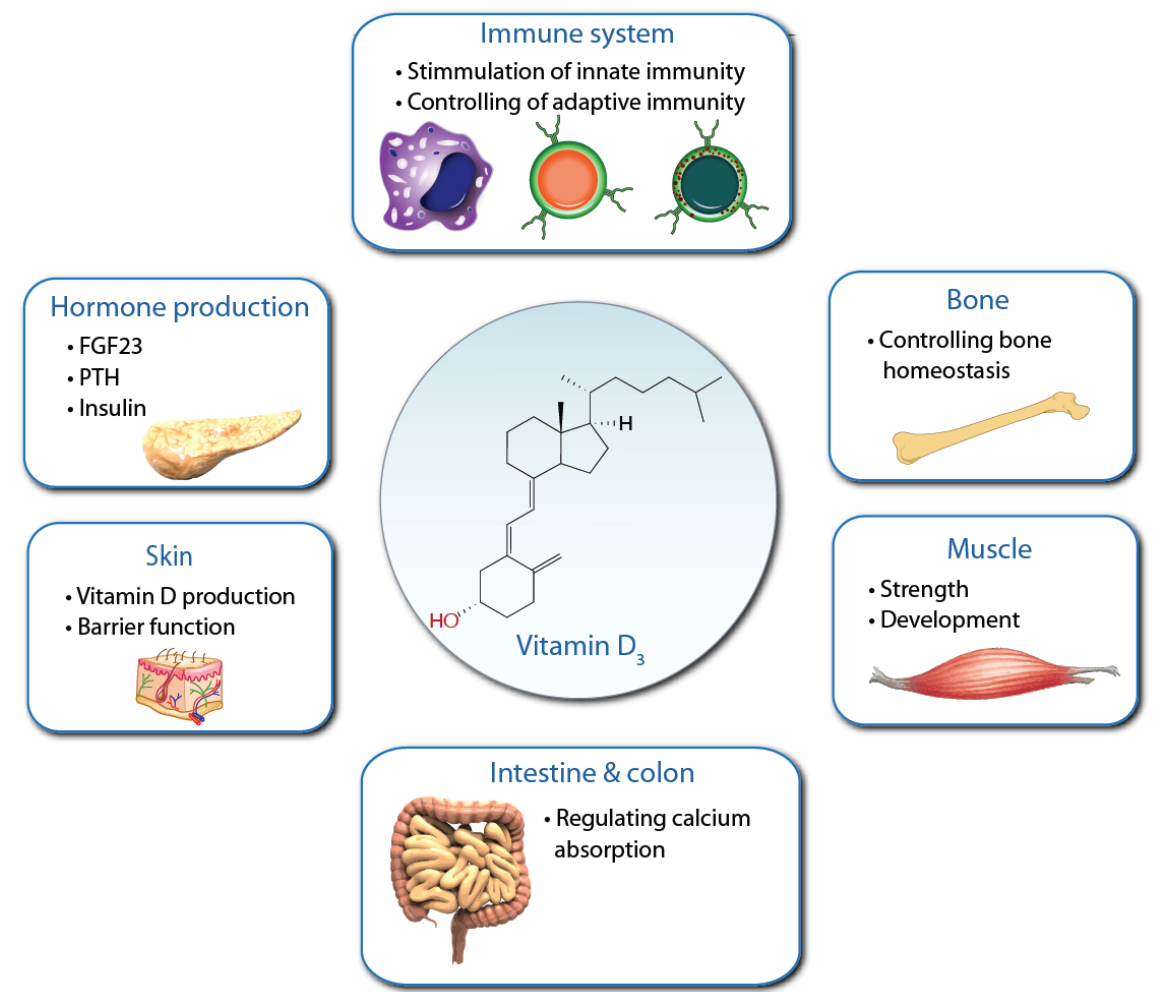
Figure 2. Pleiotropic physiological functions of vitamin D. Vitamin D 3 (center) can be produced endogenously in UV-B exposed skin. Via its metabolite 1,25(OH) 2 D 3 , vitamin D 3 activates VDR in various tissues and cell types, where it regulates the indicated major physiological functions. Funding: This publication is part of a project that has received funding from the European Union’s Horizon2020 research and innovation program under grant agreement no.